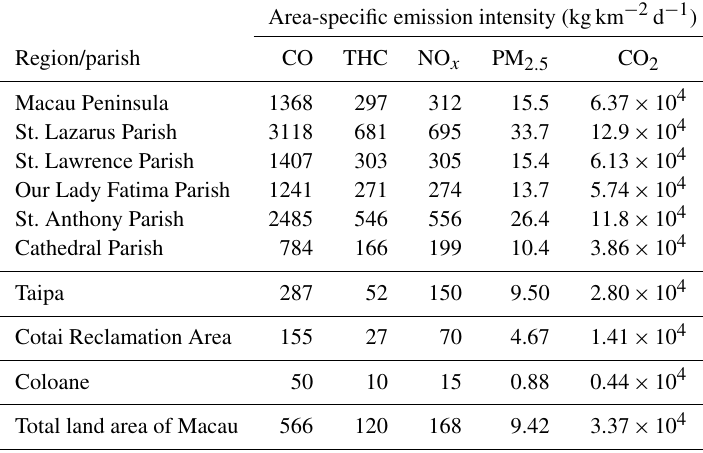
Table 6. Area-specific emission intensity of total vehicular emissions during a typical weekday in 2010.